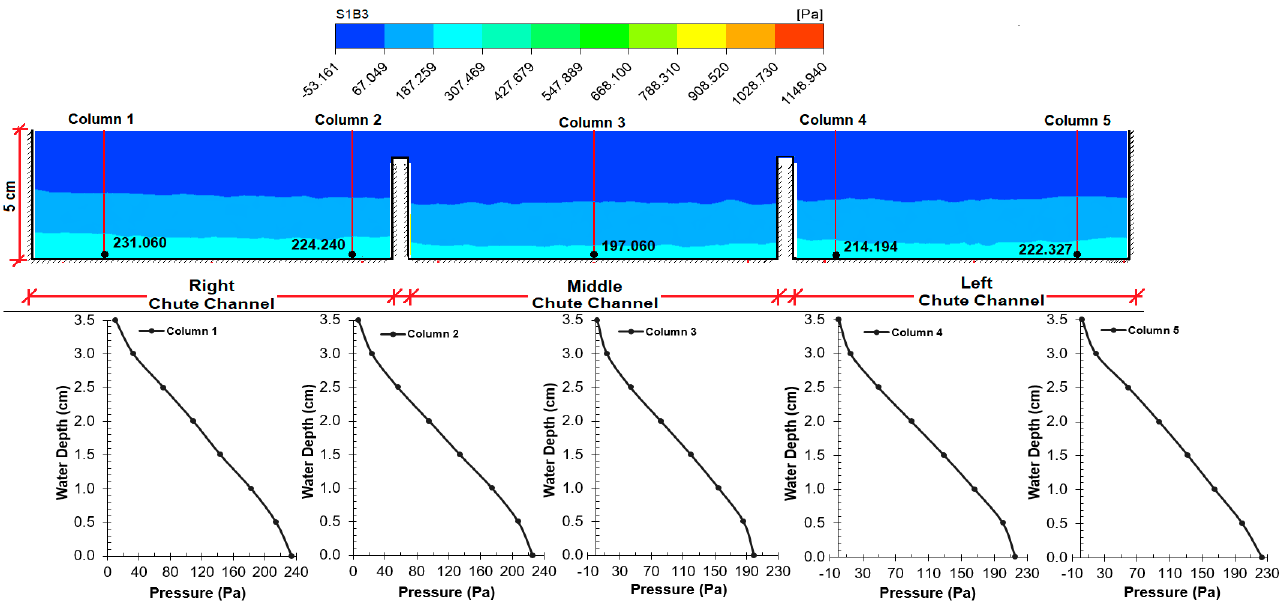
Figure 27. CFD pressure contours and depth-pressure distributions for Cross-section 3.